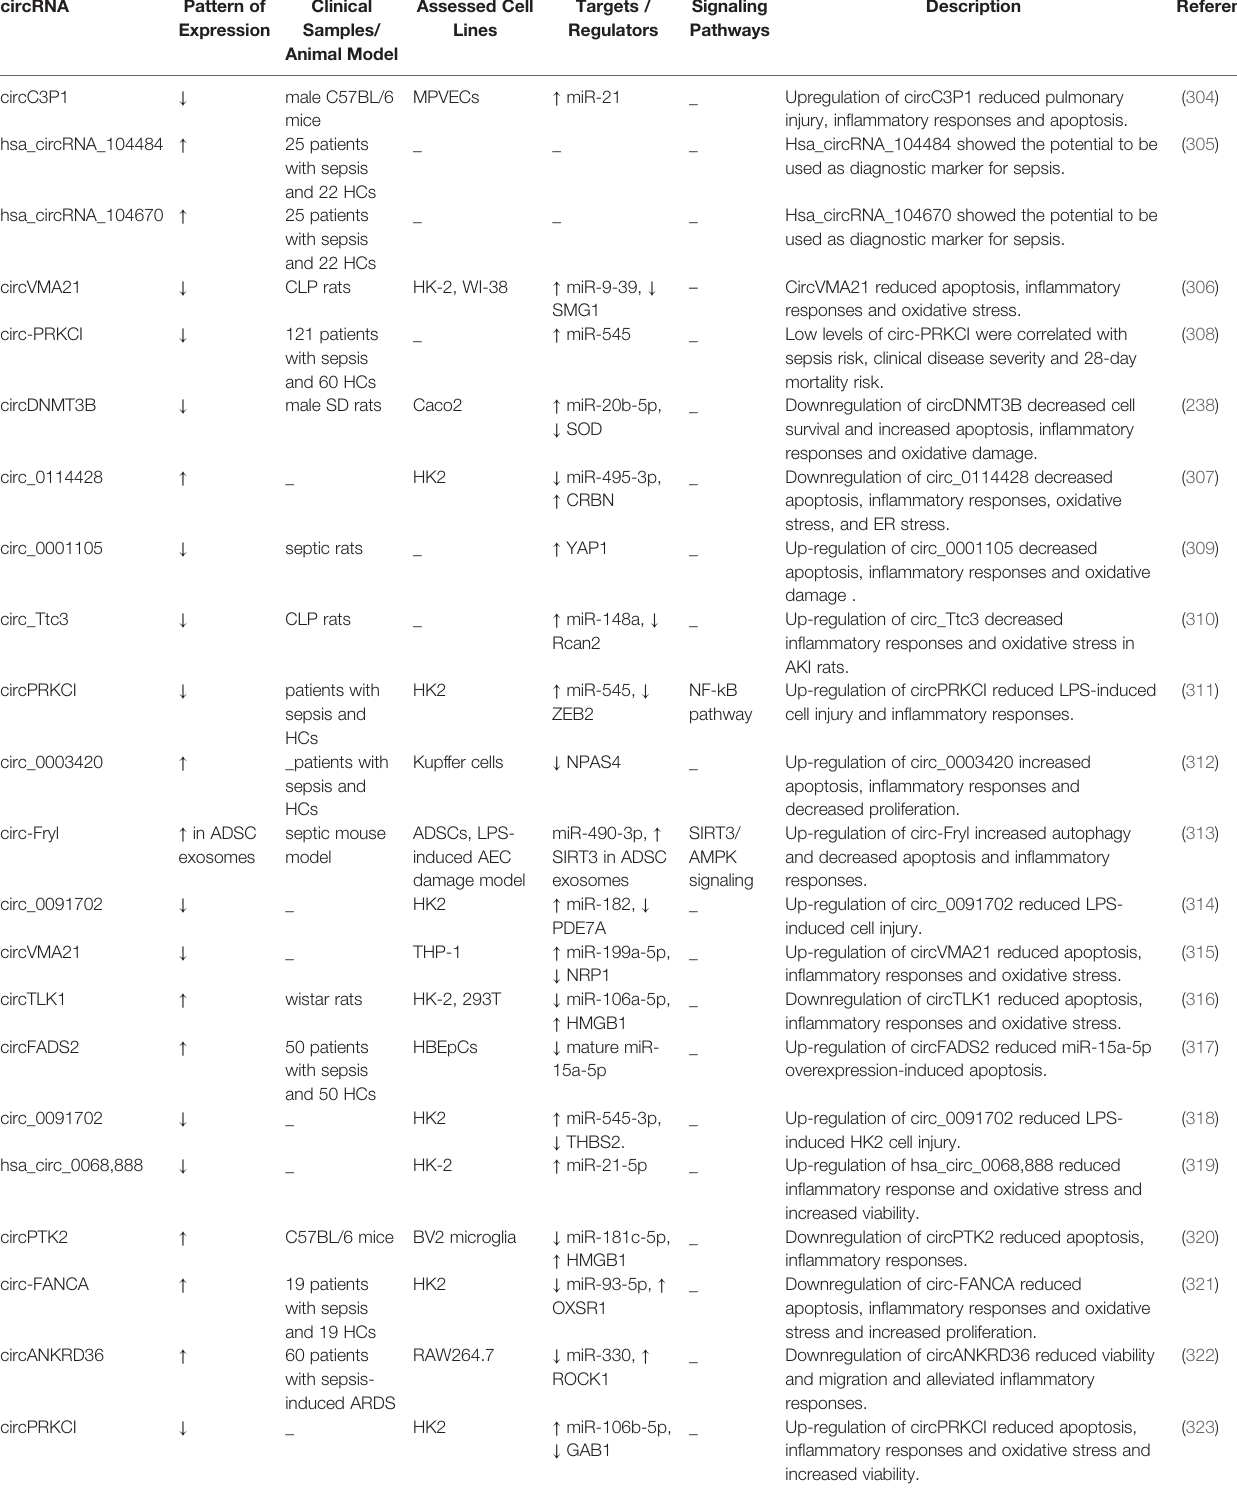
TABLE 3 | CircRNAs and Sepsis.